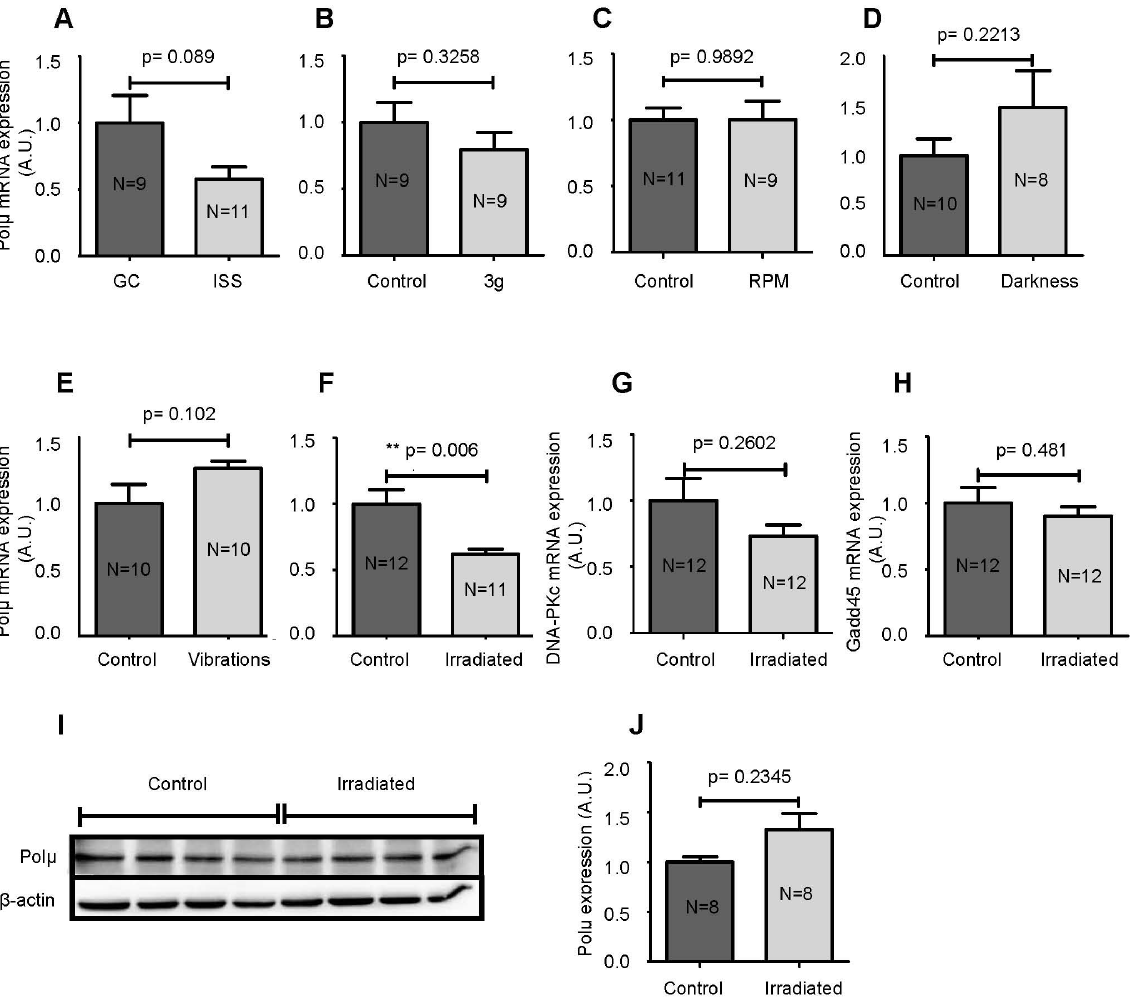
Figure 3. Effects of spaceflight conditions. Pol m mRNAs were quantified in larvae that developed in microgravity in the ISS ( A ), in hypergravity ( B ), in the RPM to simulate microgravity ( C ) or in the dark ( D ). The same study was performed with larvae subjected to a mechanical stress ( E ) or the ISS radiation environment ( F ). The effects of space radiation on DNA-PKc ( G ) and Gadd45 ( H ) mRNAs and on the amount of Pol m protein ( I and J ) were also investigated. Western blot results were analyzed and quantified by densitometry using a Fusion Fx7 imaging system (Vilber Lourmat, Marne-la-Valle´e, France) and Pol m expression was normalized to b -actin ( J ). Each lane of the western blot contains proteins from 3 larvae. Results are expressed as the mean 6 SEM. ‘‘A.U.’’ stands for ‘‘arbitrary units’’.